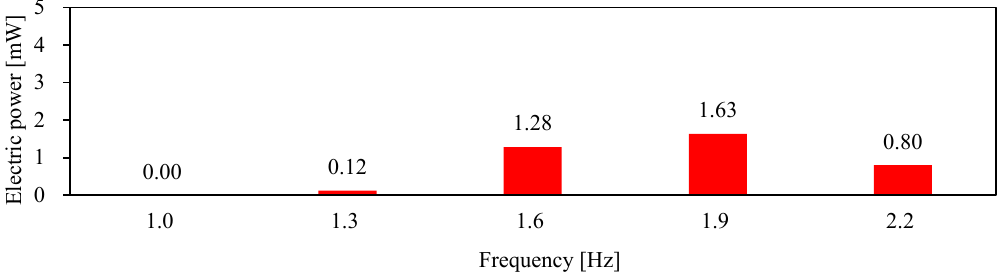
its maximum at approximately 1.9 Hz, whereas at 1.0 Hz, the amount of vibration power generated was zero as no relative displacement was indicated between the mass block and support point. Figure 16. Effect of periodic excitation signal frequency on vibration displacement.